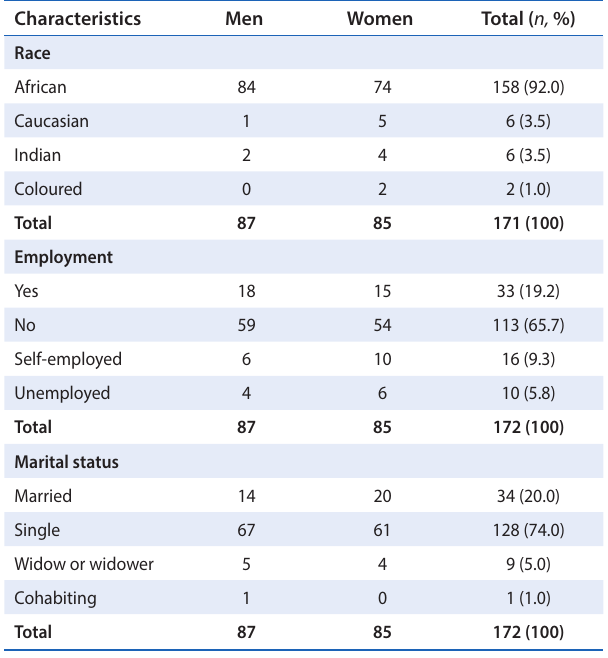
Table 1b: Other demographic distribution ( n = 172) Level of